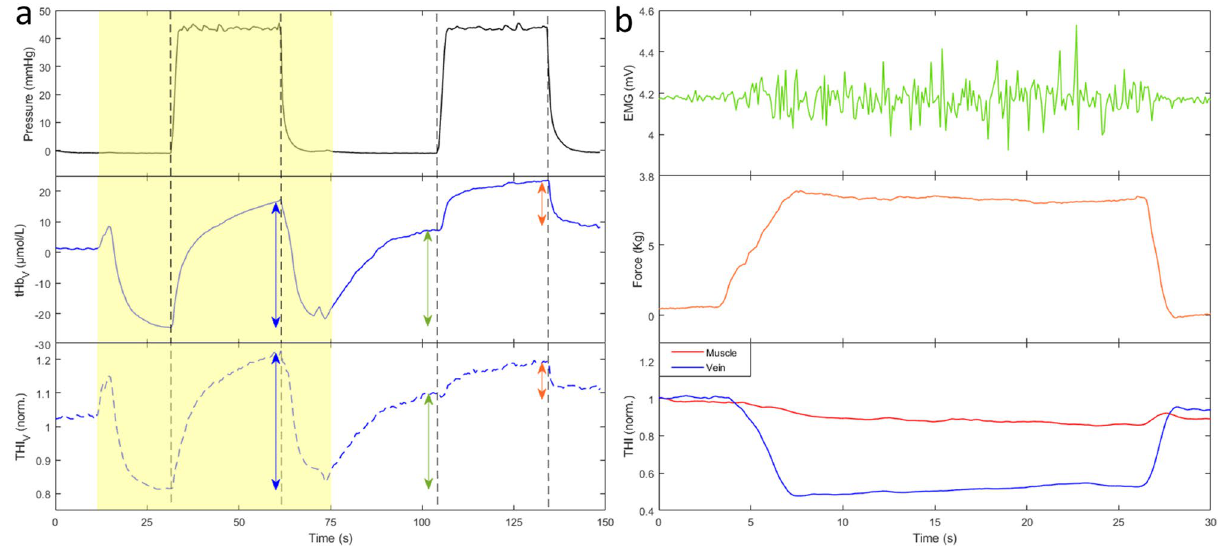
Figure 8. ( a ) Effect of postural changes on blood volume indices in a representative recording. From top to bottom, cuff pressure, tHb V and THI V collected from a single NIRS probe placed over the basilic vein (same set-up of Fig. 1b). The arm was moved from below to above (yellow-shaded area) and again returned to below heart level. Proximal venous occlusion (40 mmHg) was also performed for comparison, as indicated by the cuff pressure signal. Note that similar increases in blood volume are produced by venous occlusion (blue double- arrows) and arm lowering (green double-arrows). Much smaller effects are produced by venous occlusion when performed in the dependent arm (orange double-arrows). Vertical dashed lines indicate the beginning of cuff inflation and deflation. ( b ) Effect of muscle contraction on blood volume indices in a representative recording. Recordings are collected from the calf muscles during isometric plantar flexion of the ankle, the subject laying prone. From top to bottom, the electromyographic signal (EMG, measured over the distal portion of the soleus muscle), the force (measured at the forefoot) and THI signals form two probes, one located over an intramuscular soleus vein (blue) and one over a more distal portion of the same muscle (red). Note the different magnitude of contraction-related changes of THI at the two